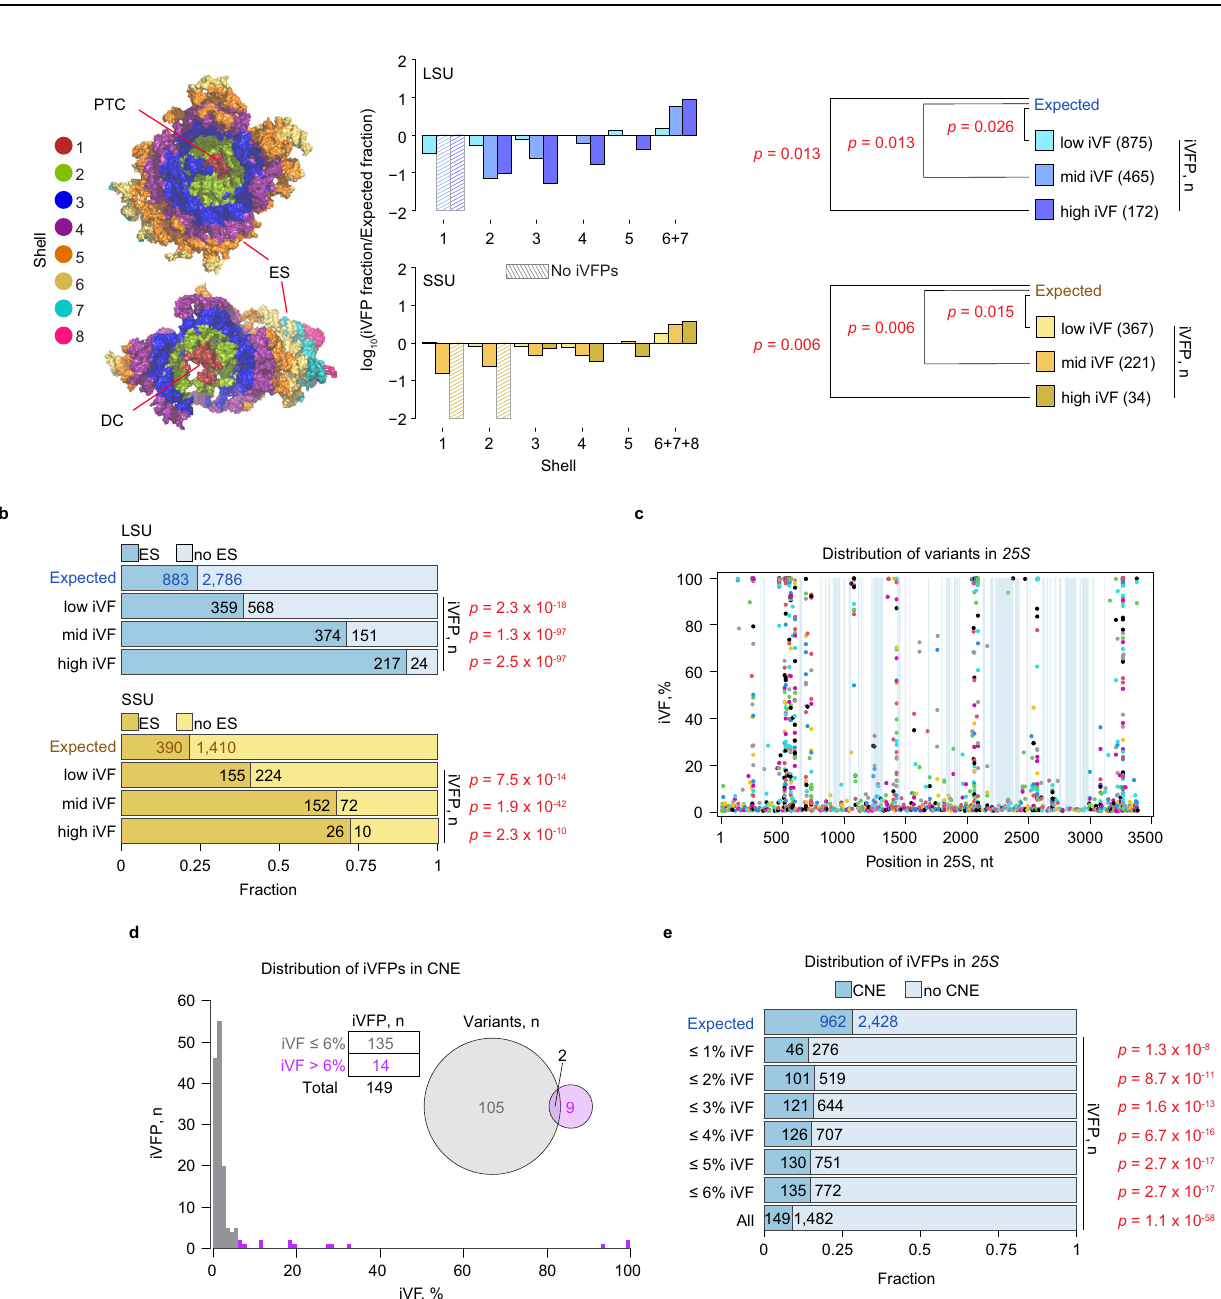
numberofiVFPsintwogroups(belowandabove6%;left)andtheoverlapbetween the variants from the two groups (right; two variants have iVFPs with iVFs both below and above 6% iVF across different isolates). e Distribution of iVFPs with different iVF cutoffs within ( “ CNE ” ) and outside ( “ no CNE ” ) of the CNEs. For a , P - values were calculated with two-sided Wilcoxon rank-sum exact test, for b and e — with two-sided Fisher ’ s exacttest. “ Expected ” distribution wascalculatedbasedon thedistributionoftotalrRNAnucleotidesacrosstheshells( a )orwithinandoutside of ES ( b ) or CNE ( e ; see “ Methods ” ). All reported P -values are adjusted for multiple hypothesistestingusingBenjamini – Hochbergcorrection.Detailsofstatisticaltests and source data are provided as a Source data fi